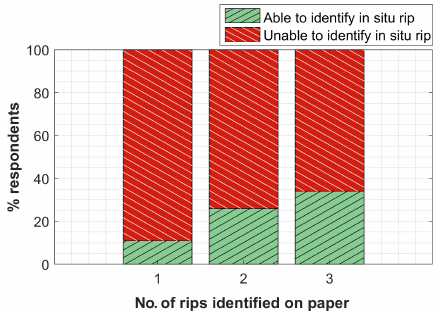
Figure 6. The percentage of respondents able to identify the in situ rip (green bars) vs. those unable to identify the in situ rip (red), presented as a function of their ability to identify rips on